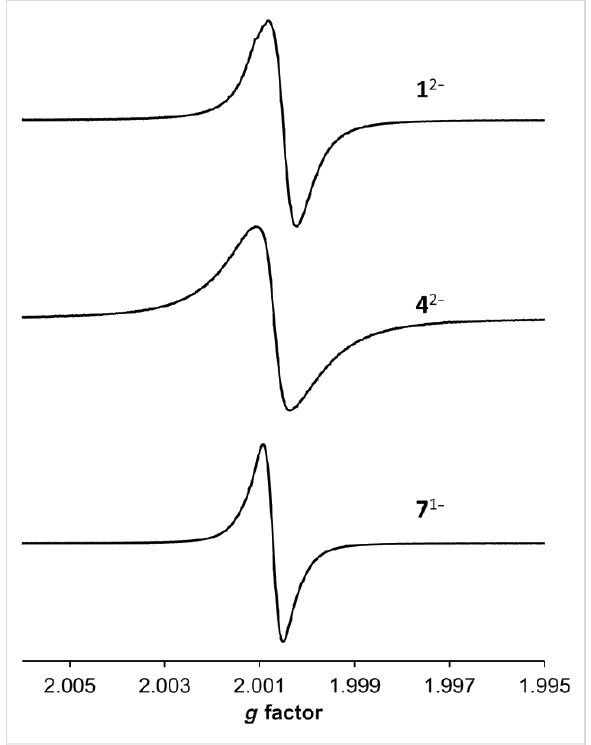
Figure 3: Fluid solution EPR spectra recorded at 297 K for the two electron reduced species of compounds 1 and 4 and the one electron reduced species of 7